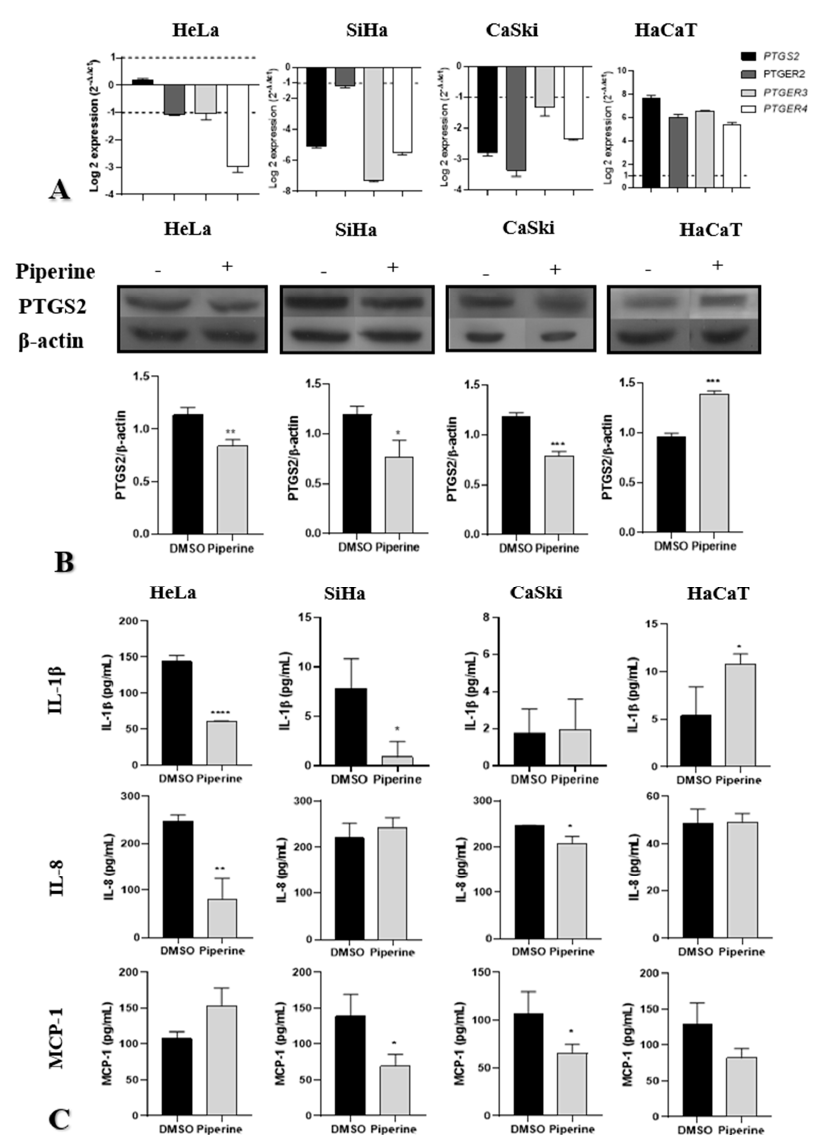
**** vs. control, p < 0.0001.